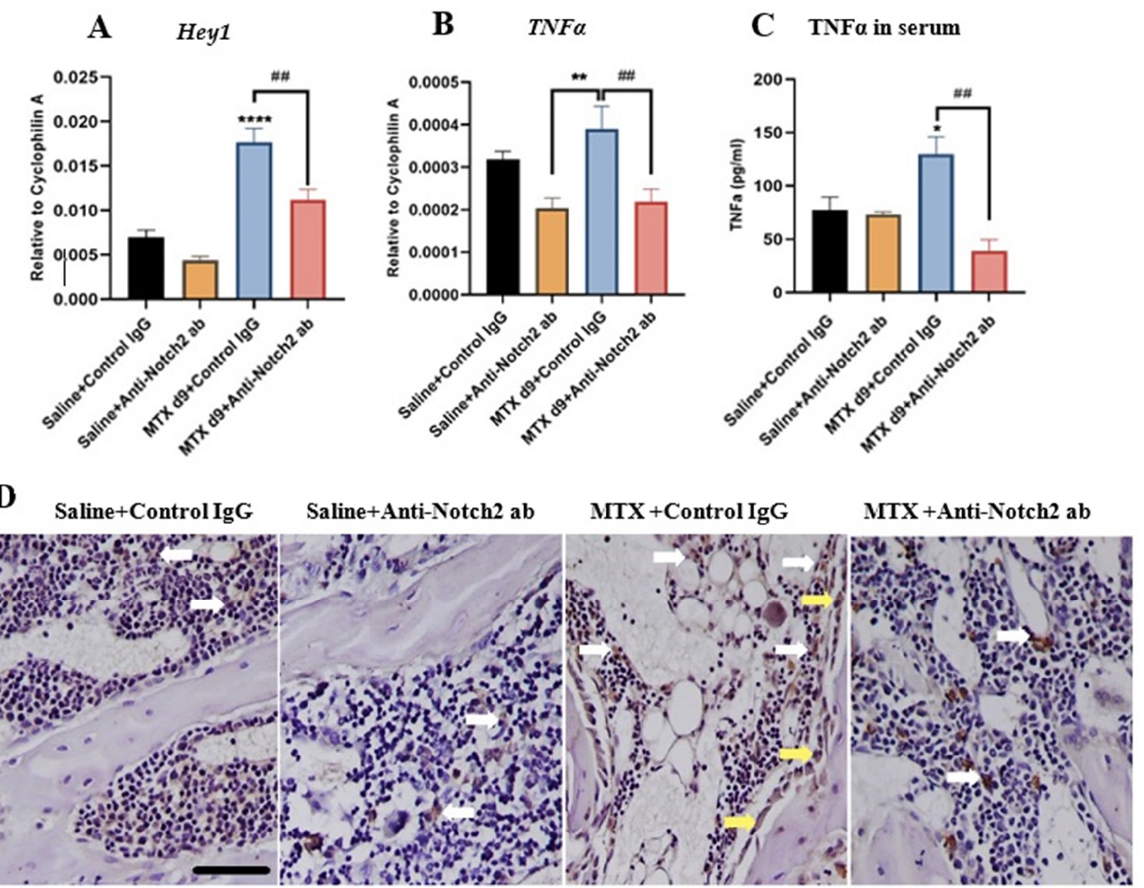
Figure 4. Effects of anti-Notch2 antibody (ab) treatment on expression of Notch target gene Hey1 and inflammatory cytokine TNF α in bone and serums of rats on day (d) nine after the first MTX injection. ( A ) Hey1 mRNA expression levels as evaluated by RT-PCR. ( B ) TNF α mRNA expression levels in bones. ( C ) TNF α protein levels in serum (pg/mL) as assessed by ELISA. ( D ) Representative images (taken from the lower region of secondary spongiosa of metaphysis bone) for TNF α immunostaining of rat bone and bone marrow from various treatment groups, with MTX+Control IgG group illus- trating more abundant positivity (bone marrow cells (white arrow heads) and osteoblasts (yellow arrow heads) when compared to the MTX+Anti-Notch2 antibody treatment group. Scale bar is 50 µ m. * p < 0.05, ** p < 0.01 and **** p < 0.0001 compared to the control or the anti-Notch2 antibody alone treatment control, and ## p < 0.01 when compared between MTX treatment